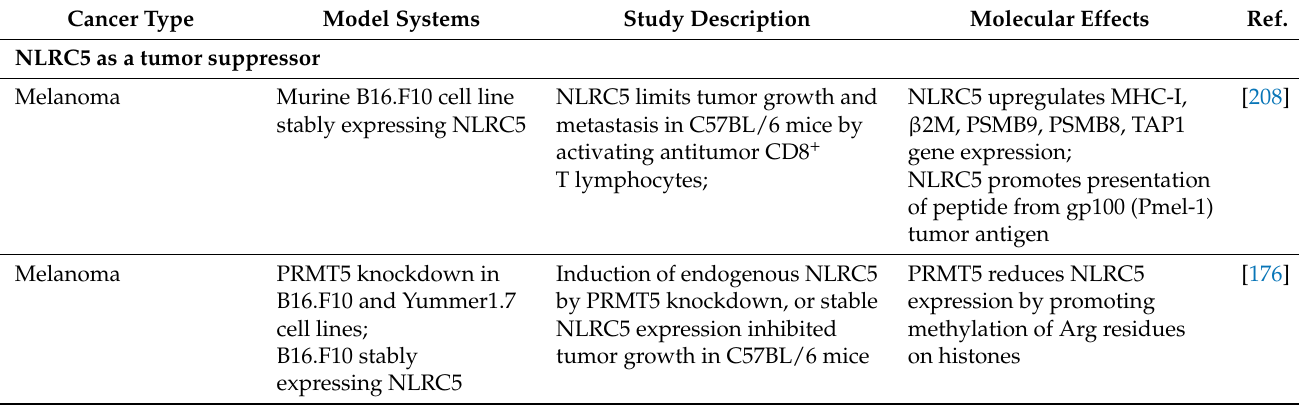
Table 1. Studies ascribing antitumor or protumor roles to